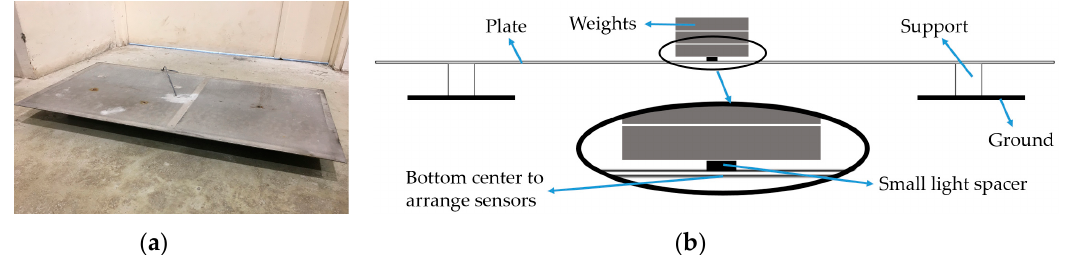
Figure 3. Experimental design of static tests. ( a ) Actual aluminum plate; ( b ) Schematic diagram of the tests.